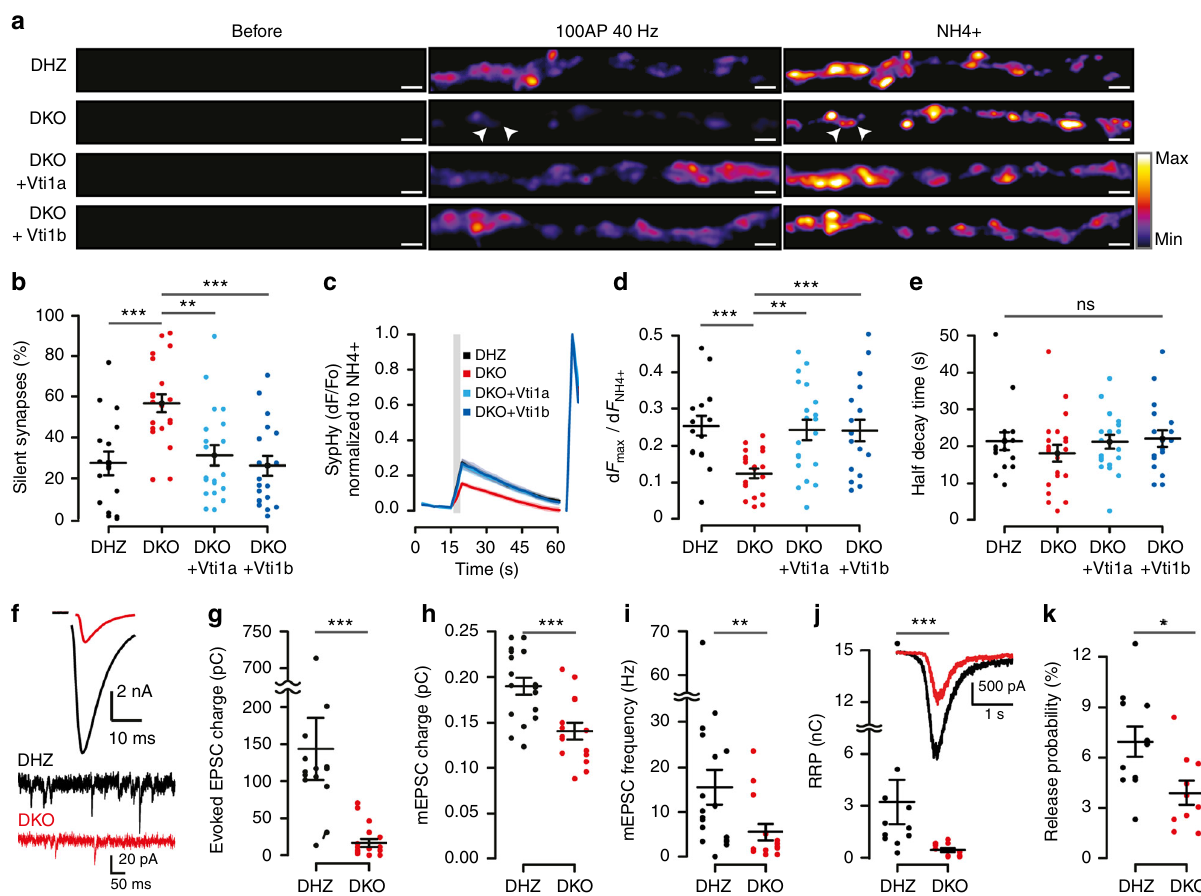
Fig. 2 SV fusion is impaired in Vti1a/b-de fi cient neurons. a Examples of SypHy-labeled synapses from single DIV-14 neurons before, during HFS (100AP, 40 Hz) and NH 4 + superfusion. Arrowheads point at examples of silent synapses. Intensity color-code used for SypHy. Scale bar = 2 µ m. b Increased percentage of silent synapses in DKO neurons (DHZ: 56.65 ± 4.45, n = 17; DKO: 27.28 ± 5.77, n = 21; DKO + Vti1a: 31.21 ± 5.14, n = 20; DKO + Vti1b: 26.03 ± 4.95%, n = 19; ANOVA). c Average SypHy traces of SV fusion in responsive synapses upon HFS (gray rectangle) normalized to the maximum intensity upon NH 4 + superfusion (right traces). Shaded regions indicate SEM. d Reduced fraction of SV fusion in responsive synapses, measured as maximum HFS intensity over NH 4 + response, in DKO neurons (DHZ: 0.25 ± 0.03, n = 17; DKO: 0.12 ± 0.01, n = 21; DKO + Vti1a: 0.24 ± 0.03, n = 20; DKO + Vti1b: 0.24 ± 0.03, n = 19; ANOVA). e Similar half decay time of the maximum HFS response between groups (DHZ: 21.45 ± 0.44, n = 17; DKO: 18.06 ± 2.25, n = 21; DKO + Vti1a: 21.24 ± 1.20, n = 20; DKO + Vti1b: 22.13 ± 2.23 s, n = 19; Kruskal – Wallis). f Representative traces of evoked (top)